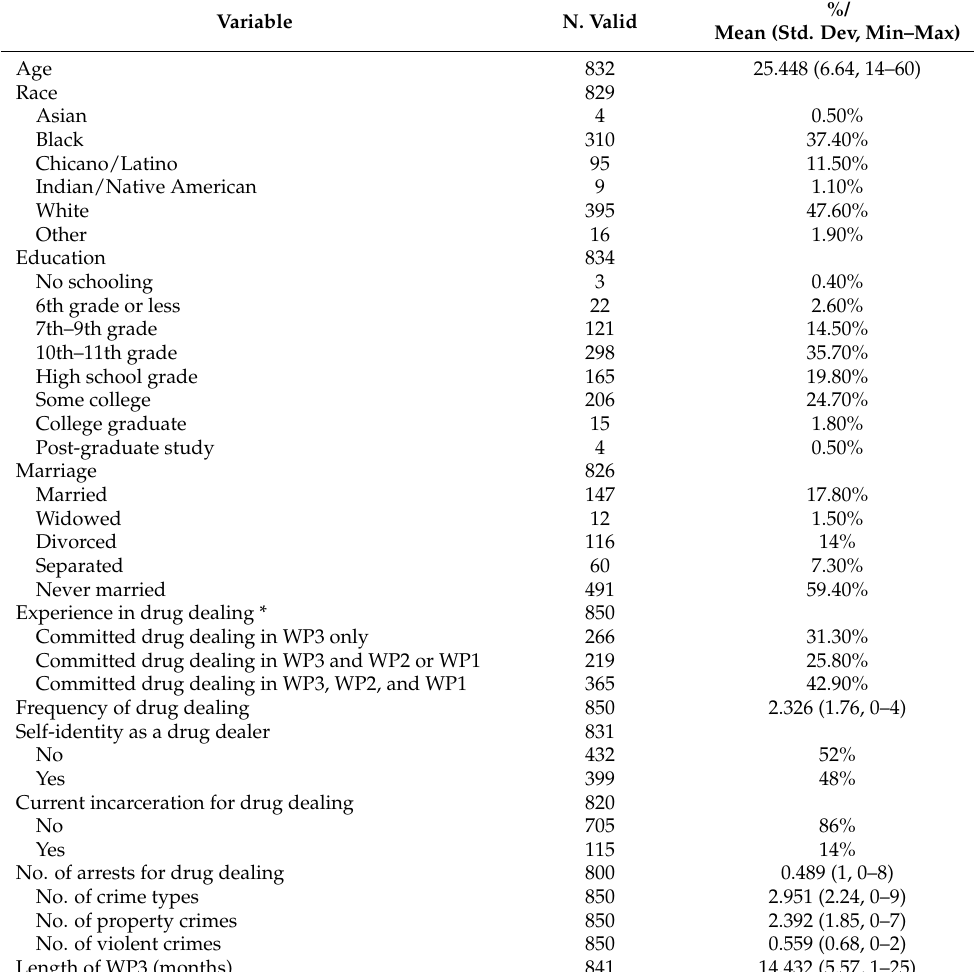
Table 1. Demographic statistics for drug dealer sample in the Second RAND Inmate